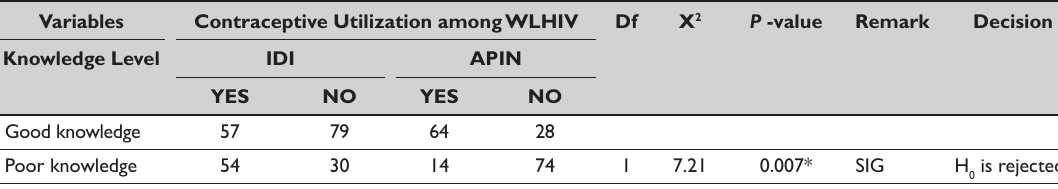
Table 6: Levels of knowledge of contraceptive options and contraceptives utilization among study participants